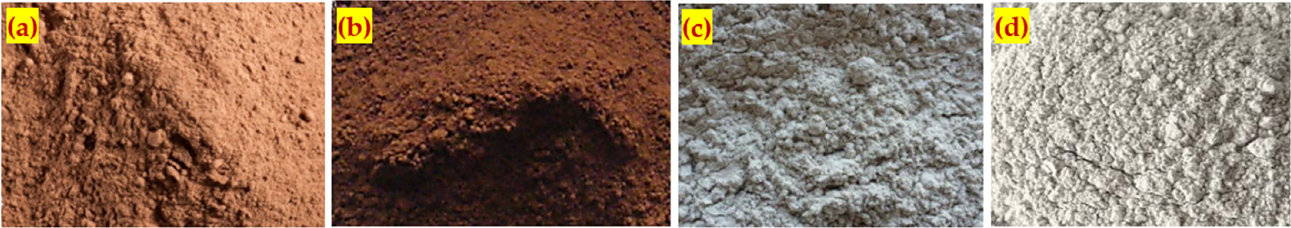
Table 1. The mixing combination of the